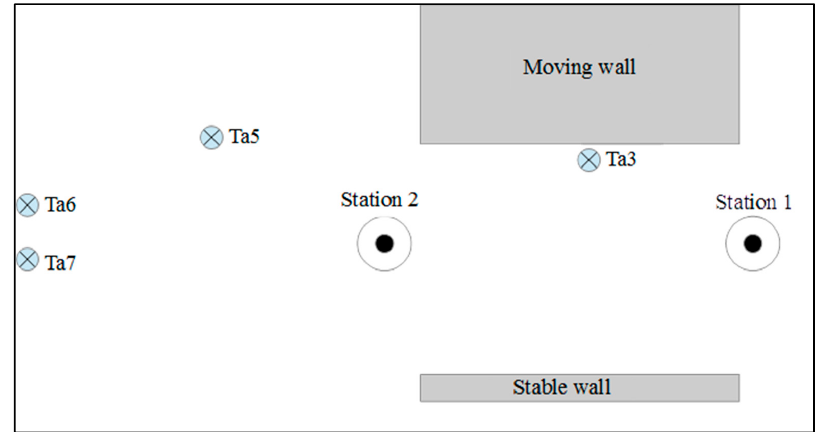
Figure 2. A sketch showing the position of the test building (moving wall), a stable wall and scan